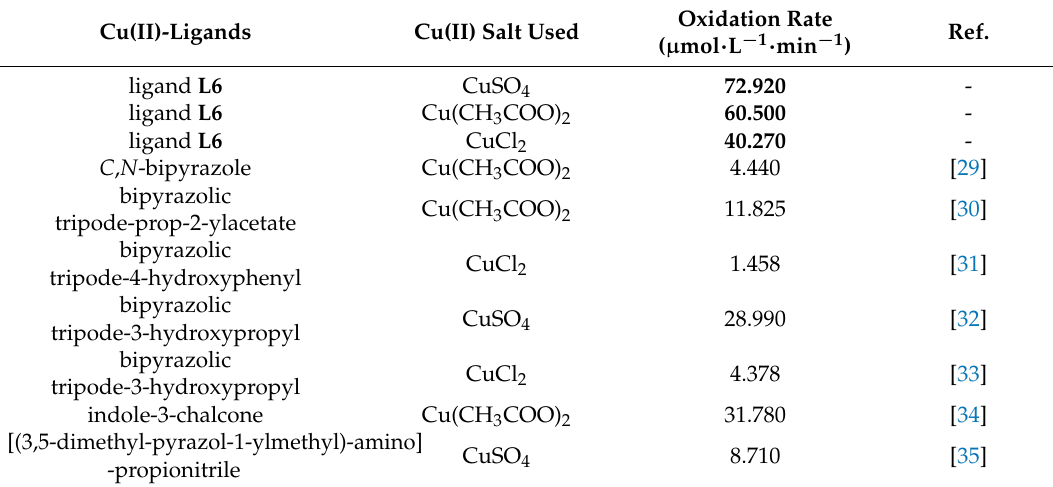
Table 5. Comparison of the catalytic activity of various catalysts toward oxidation of the catechol into o -quinone, established in the same conditions, as given in previous